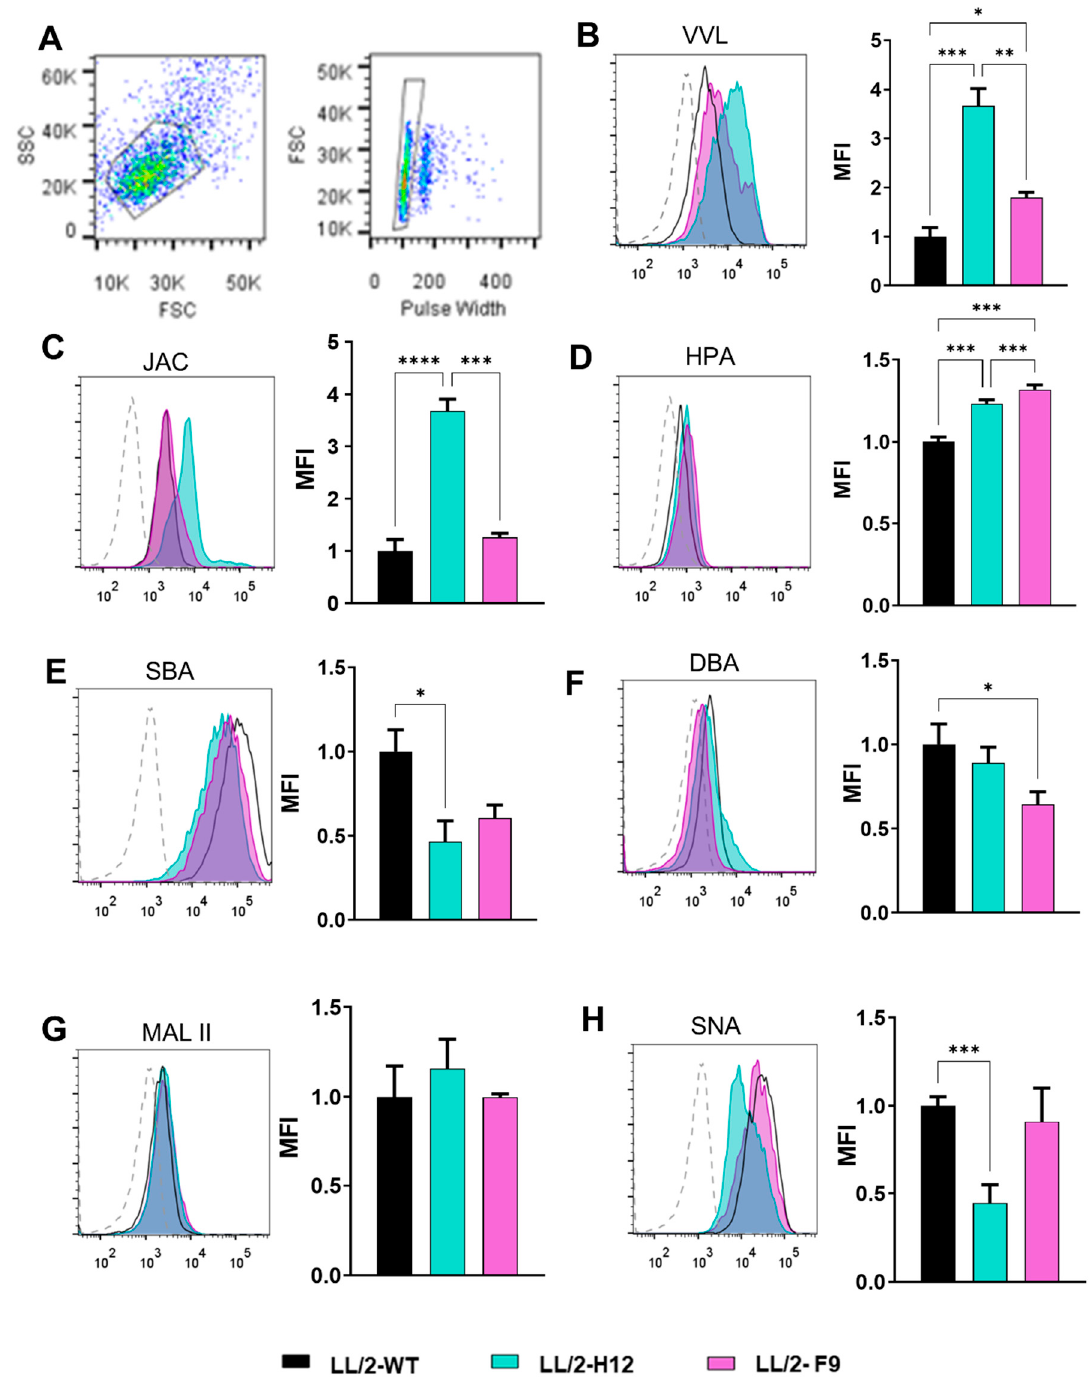
Figure 3. Surface glycan motifs of Tn-bearing LL/2 and WT cells determined by lectin recognition. LL/2 cells were stained with plant lectins and analyzed by flow cytometry. ( A ) Representative gating strategy. B-H) Histogram and median fluorescence intensity (MFI) are shown for LL/2-Tn + -H12 (green) and LL/2-Tn + -F9 (pink) relative to WT LL/2 cells for VVL ( B ), JAC ( C ), HPA ( D ), SBA ( E ), DBA ( F ), MAL II ( G ) and SNA ( H ). Dotted histograms represent the control condition consisting of cells incubated only in the presence of streptavidin-FITC. The specificity of lectins is shown in Supplementary Table S1. Asterisks represent significant differences (* p < 0.05, ** p < 0.01, *** p < 0.001, **** p < 0.00001).